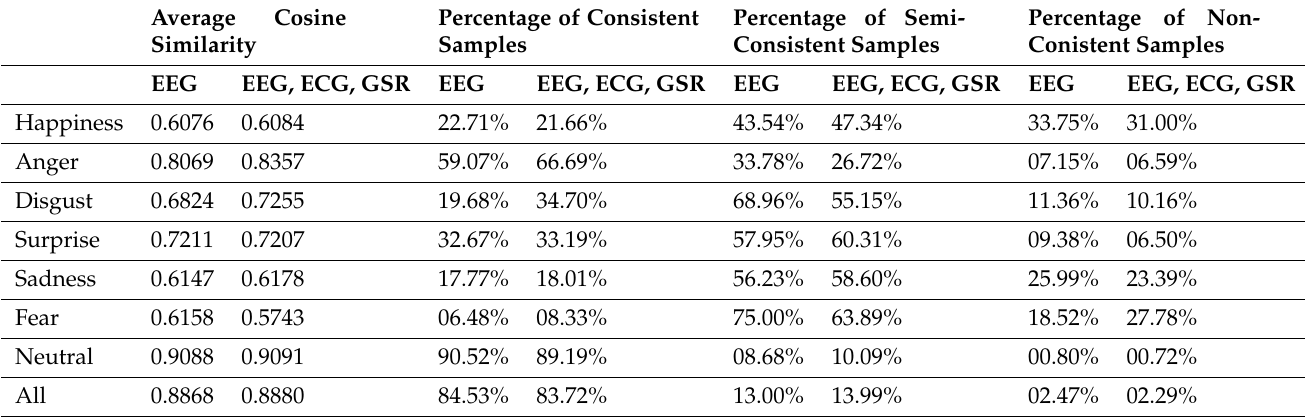
Table 12. Analysis of cosine similarity for Experiments 5 and